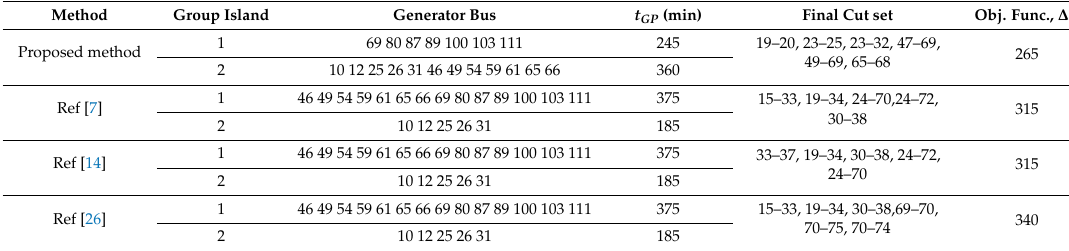
Table 6. Methods for island’s backbone energizing approach.